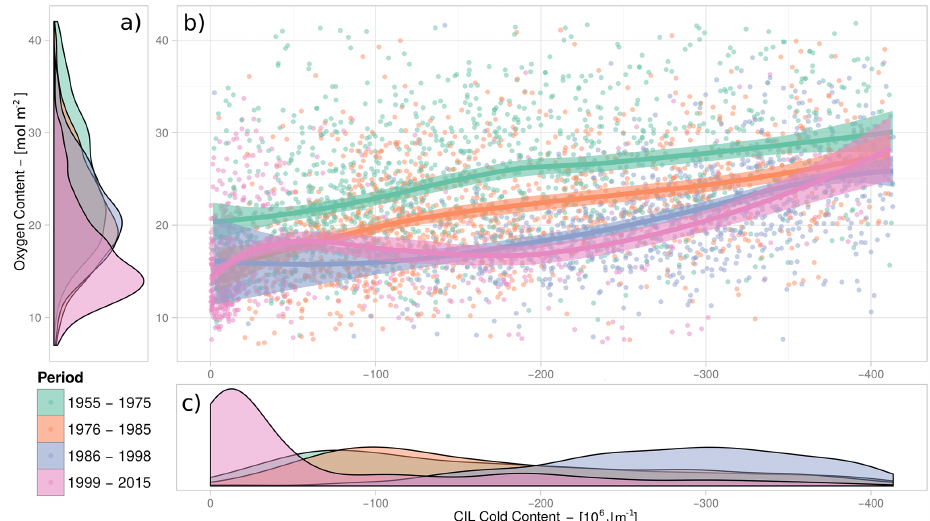
Figure 7. Impact of convective ventilation on oxygen inventory. Frequency distributions of (a) oxygen inventory and (c) cold intermediate layer (CIL) cold content diagnosed from ship-based and Argo profiles for different periods (color legend). (b) LOESS regressions (second degree polynomials, span = 0.75, Cleveland et al., 1992) between oxygen inventory and CIL cold content for the different periods (confidence interval α = 0 . 99). The positive relationships observed during each period illustrate the ventilating action of CIL formation as a source of oxygen to the intermediate levels. The shift of these relationships towards lower oxygen inventories indicates shift in the oxygen budgets (higher consumption) that are independent of the intensity of CIL